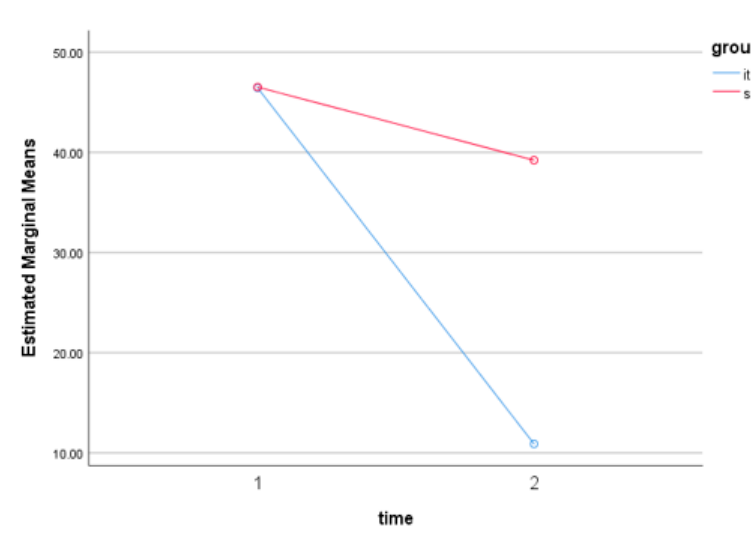
Figure 4. Estimated marginal means of NAAMY